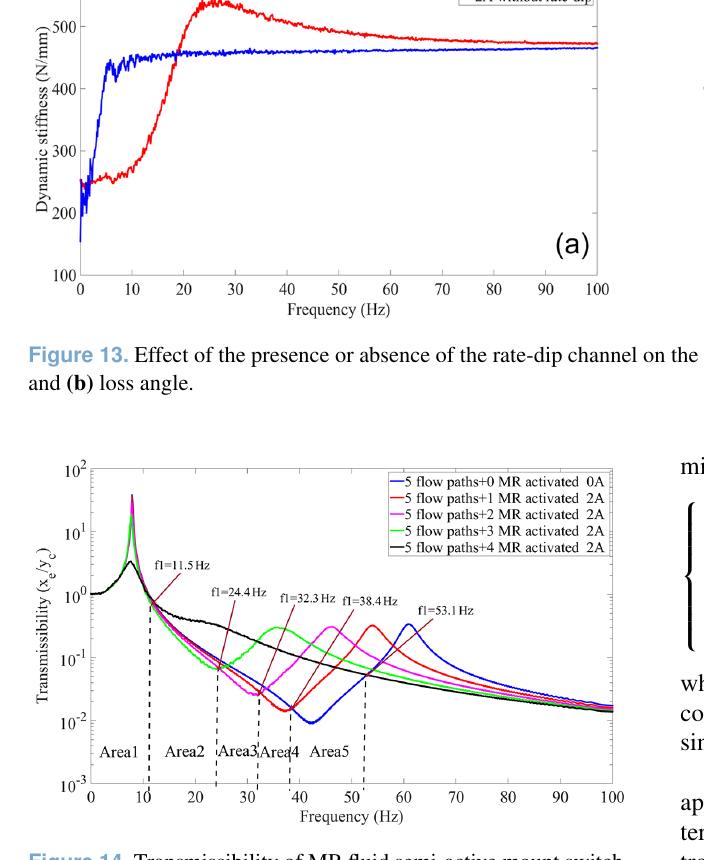
Figure 14. Transmissibility of MR fluid semi-active mount switch- ing for different controllable